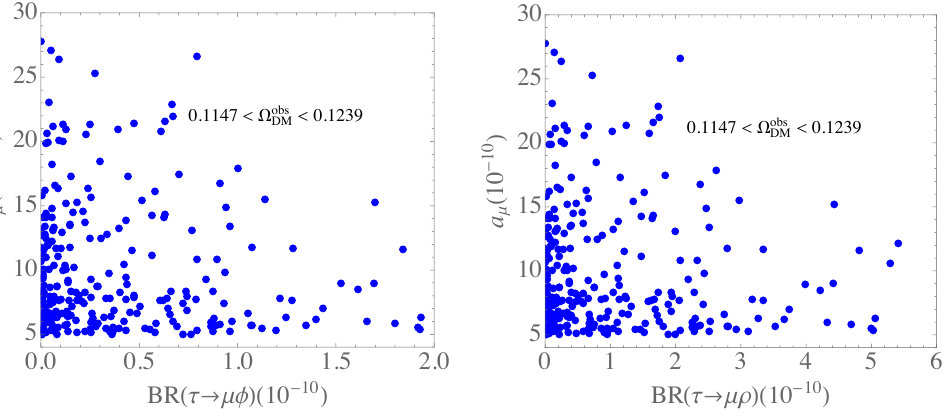
Figure 8 . Scatter plots for the correlation between a µ and BR( τ → µγ ) [left panel] and BR( τ → 3 µ ) [right panel], where the observed Ω DM h 2 constraint is included.